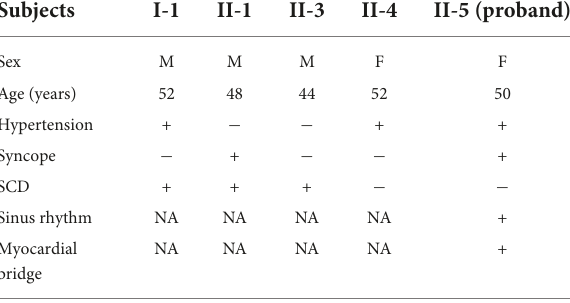
TABLE 1 Clinical data of patients in this